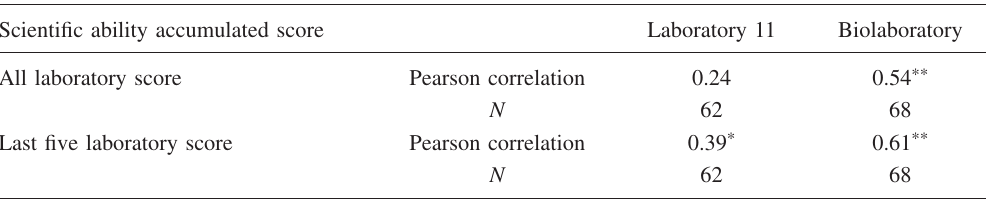
TABLE II. Correlations between the accumulated scientific ability scores and the scores on the laborato- ries without scaffolding. Bold font shows correlations significant at level (cid:1) p (cid:3) 0.01 or (cid:1)(cid:1) p (cid:3)